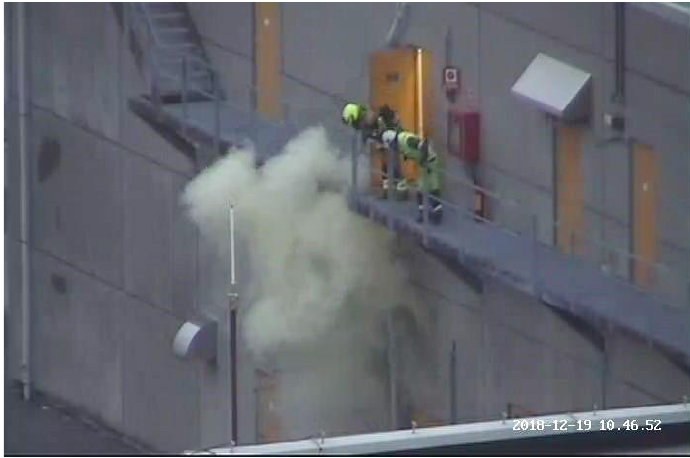
Figure 5. Pyrolysis products ventilated when briefly opening the door to the high-voltage room at 10:46:52 [16].